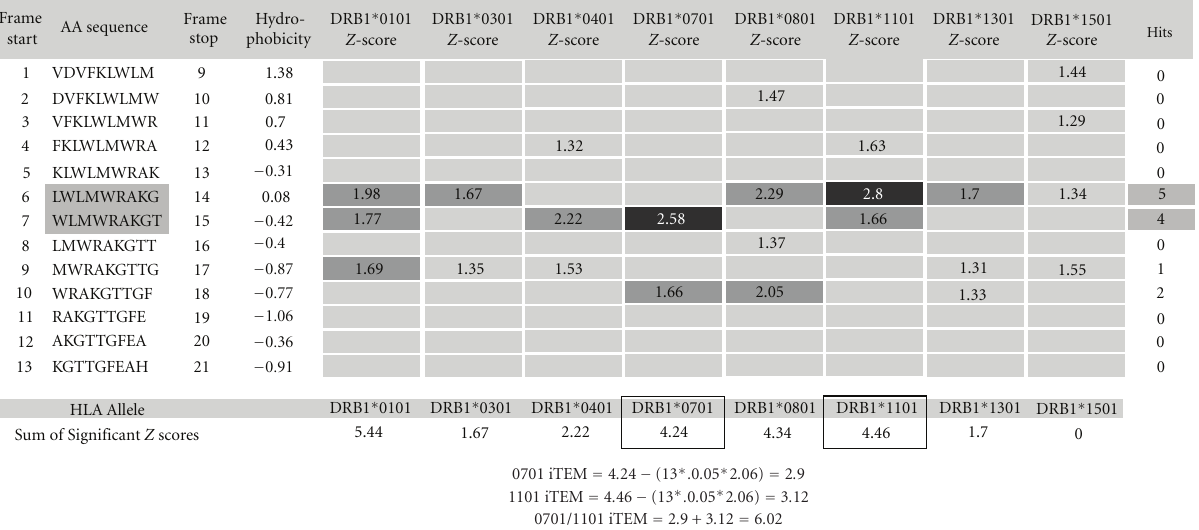
Figure 1: Calculating an iTEM score. Using the EpiMatrix report for a peptide, the iTEM score is equal to the di ff erence between the sum of significant scores for an allele (shown in the black boxes above) and the expected score for a peptide of that length. Assessments outside the top 10% ( Z -scores below 1.28) are hidden for ease of viewing the more significant scores, and assessments are shaded with di ff erent levels of darkness to highlight Z -scores that are in the top 5% (1.64–2.32) or top 1% (greater than 2.32). For a subject with two alleles, the iTEM score for each allele is calculated and then added together, as shown in the three equations within the figure. The peptide constant is equal to the product of the number of frames (13 in this example), the expected frequency of hits (0.05), and the expected value for a hit (2.06). For this peptide, an HLA of DRB1 ∗ 0701/DRB1 ∗ 1101 would be expected to respond (iTEM score: